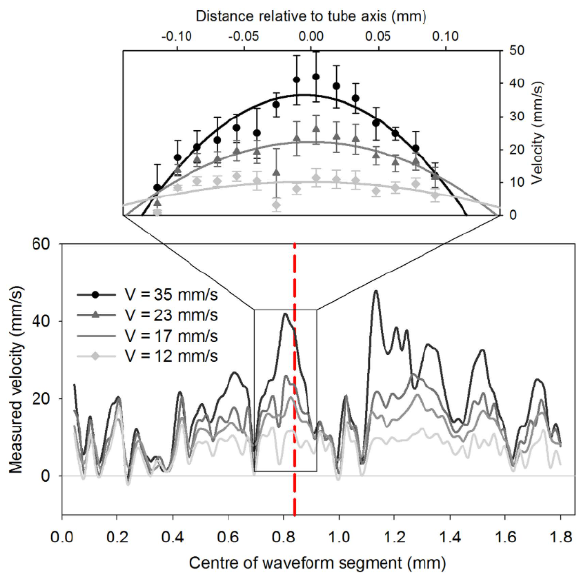
Figure 4. Profiles of velocity measurements corresponding to signal segments. Reprinted from Brunker et al., Sci. Rep., 2016, 6, 1: 20902 [23], with permission of Springer Nature. In 2019, Zhou et al. developed a scan-type OR-PAM system using a 532 nm Nd:YAG laser (GKNQL-532, Beijing Guoke Laser Co., Beijing, China) and monitored the dynamic